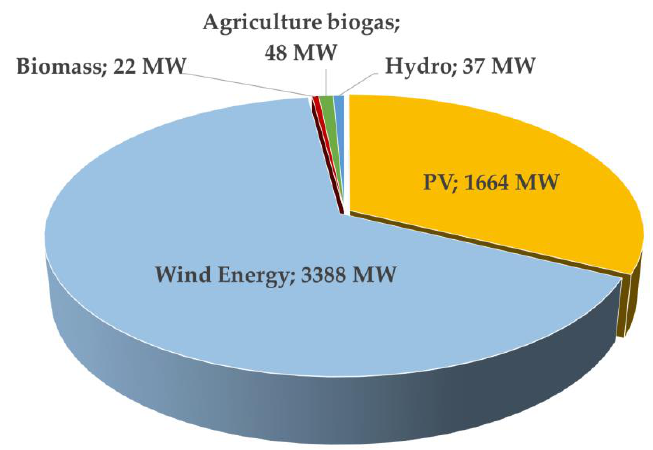
Figure 8. Expected installed capacity of RES units, resulting from the auctions conducted in the period 2016–2019 in Poland, in (MW).